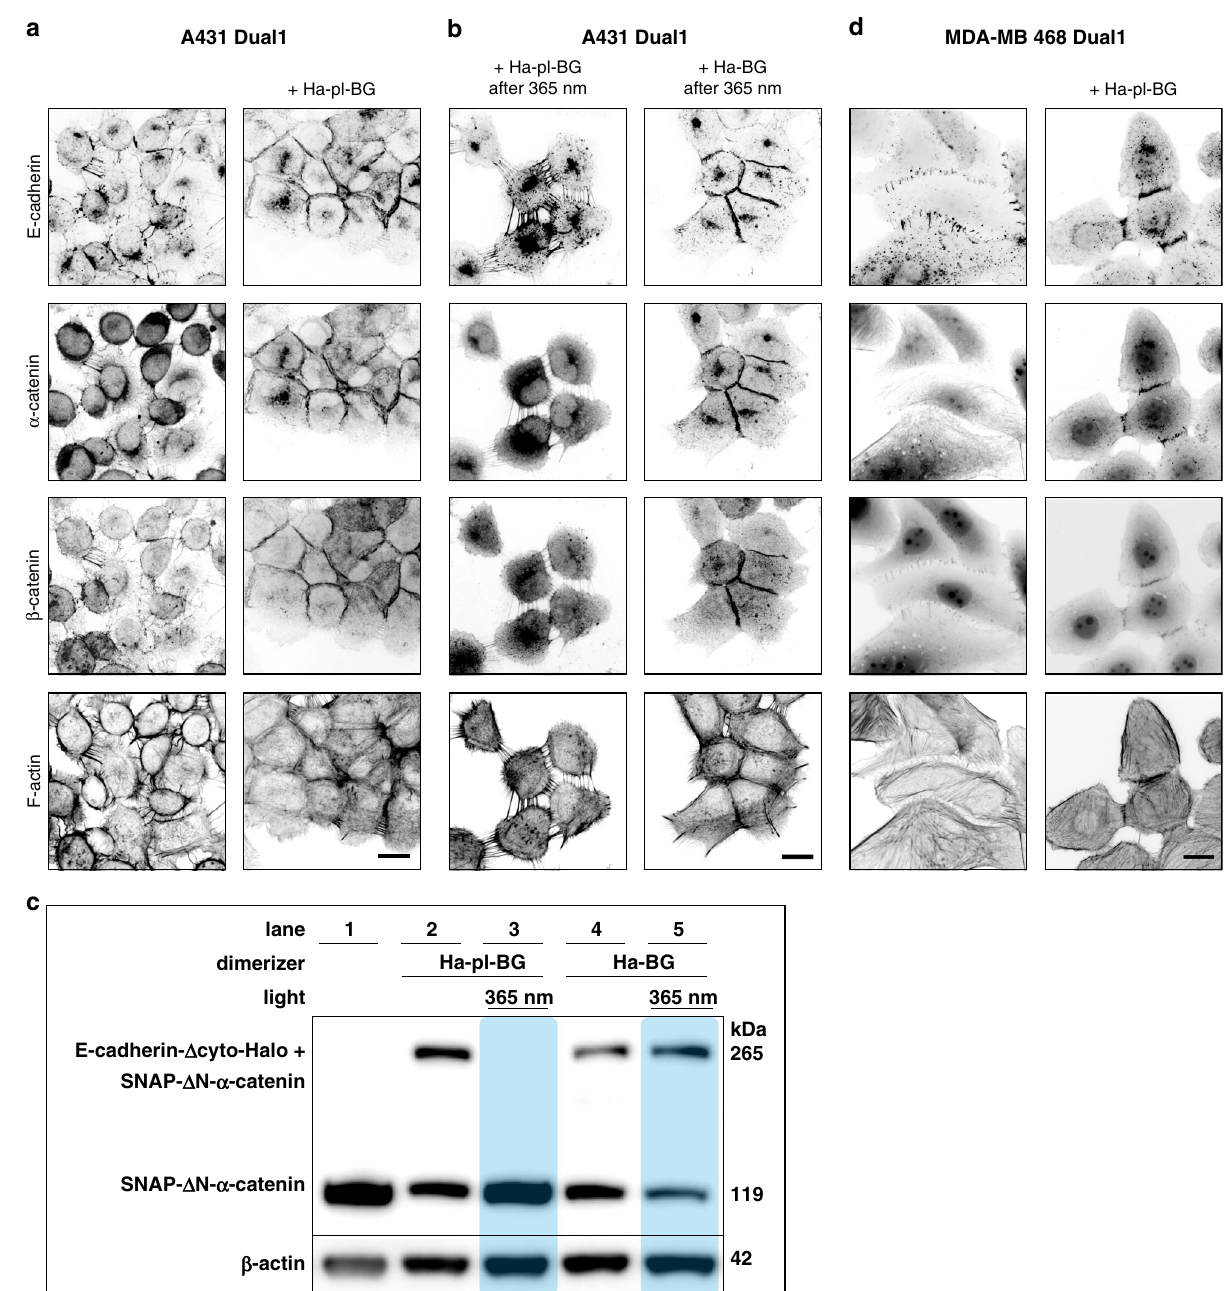
Fig. 2 Establishing a functional link between E-cadherin and α -catenin with optochemical dimerizers. a , b Immuno fl uorescence images of A431 α -catenin KO cells coexpressing E-cadherin- Δ cyto-GFP-Halo and SNAP-mCherry- Δ N- α -catenin. Without dimerizer E-cadherin shows diffuse membrane localization, whereas α -catenin and β -catenin are cytosolic. Dimerizer induced E-cadherin- α -catenin complex formation indirectly recruits also β -catenin and causes rearrangements of actin fi bers. 365 nm light disseminates Ha-pl-BG treated cells but not Ha-BG treated cells. Scale bars 20 µ m. c Western Blot analysis of E-cadherin- α -catenin complexes. Without dimerizer (lane 1) only the 119 kDa SNAP-(mCherry)- α -catenin is detected, whereas with dimerizer (lane 2 and 4) an additional band of 265 kDa is detected, resembling the hetero-dimer E-cadherin- α -catenin complex. After 365 nm light, the heavy band disappears in Ha-pl-BG treated cells but not in Ha-BG samples (lane 3 and 5). β -actin serves as loading control. d Application of LInDA to dissociate AJs in MDA-MB-468 epithelial cancer cells coexpressing E-cadherin- Δ cyto-GFP-Halo and SNAP-mCherry- Δ N- α -catenin. Filamentous actin was labeled using phalloidin conjugated with Alexa647 dye. In absence of the dimerizer, punctate E-cadherin clusters are present at the cell membrane, whereas α -catenin and β -catenin are diffuse in the cytoplasm. Addition of Ha-pl-BG induces E-cadherin mediated AJ formation by recruiting the cytosolic α -catenin and β -catenin to the cell membrane. Scale bar 20 µ